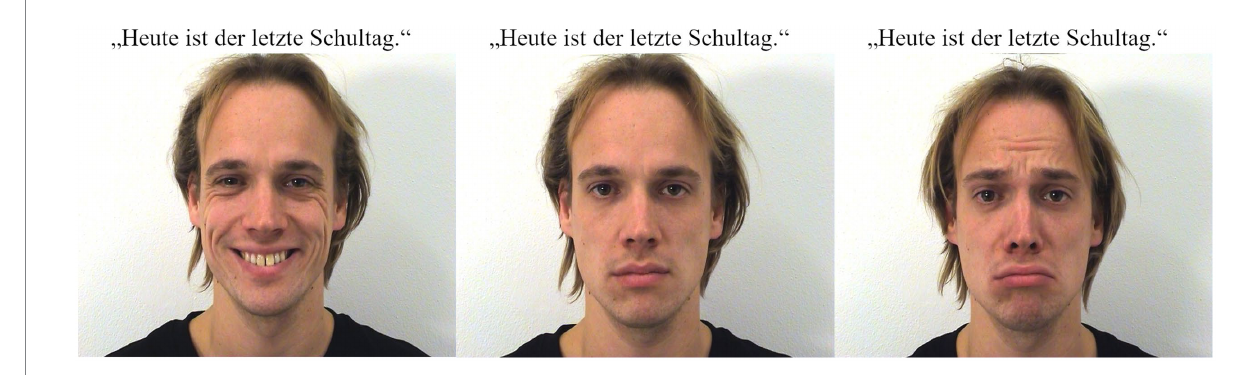
FIGURE 1 Example of the joint presentation of a target sentence and speaker image (showing happy, neutral, and sad facial expressions, respectively) during experimental trials. Image source: Amsterdam Dynamic Facial Expression Set (van der Schalk et al., 2011). Reproduced with